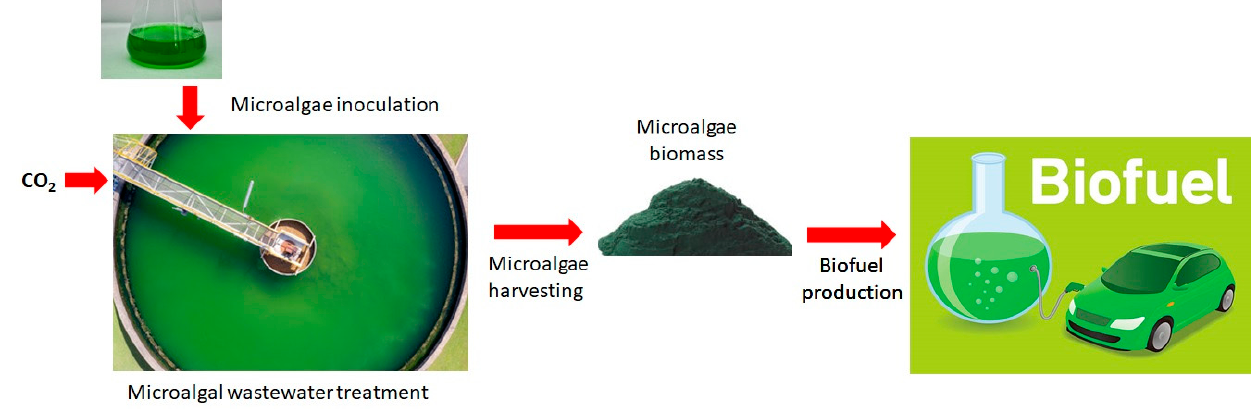
Figure 2. The representation of microalgal wastewater treatment and biofuel production.